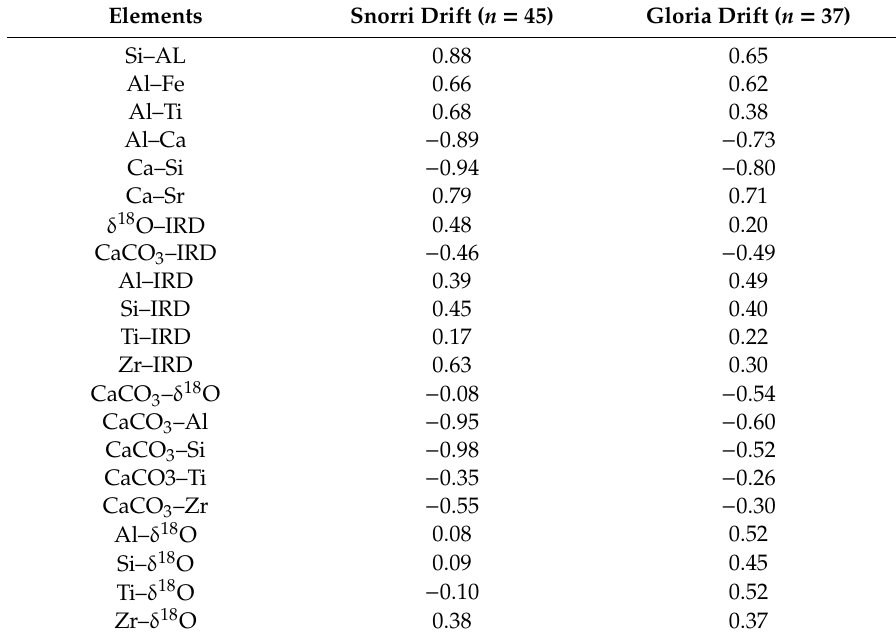
Table 4. Pair correlation coe ffi cients ( p < 0.05 ) between some elements in the Snorri (st. AI-3378) and Gloria (st. AMK-4493) drift sediment